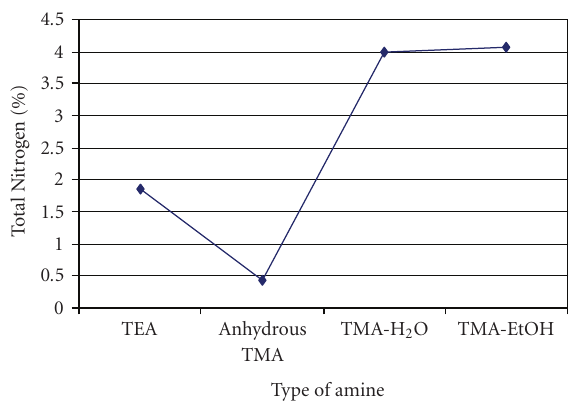
Figure 3: E ff ect of amine type on the nitrogen content (after immersing in 6% DVB polymer in TMA at room temperature for 4 days).